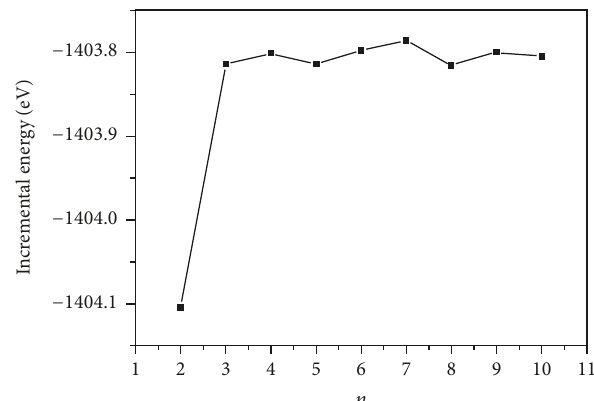
Figure 3: Variation of incremental energies of U(001) slabs as a function slab